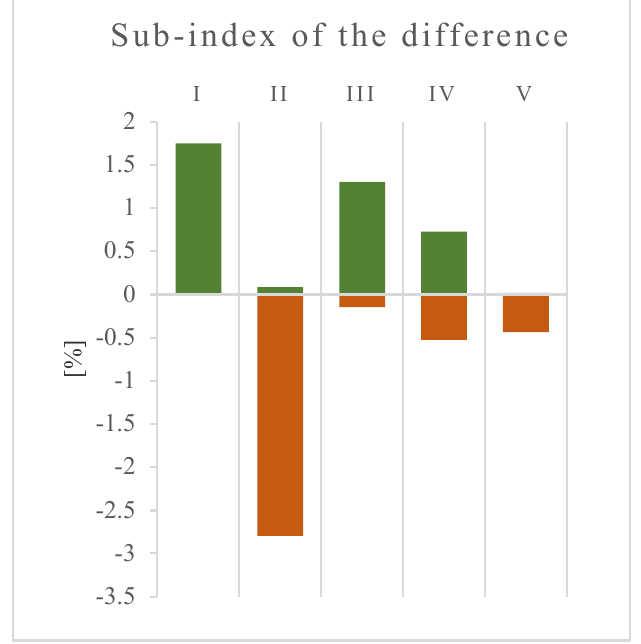
Figure 4. The structure of the DI in 2006.